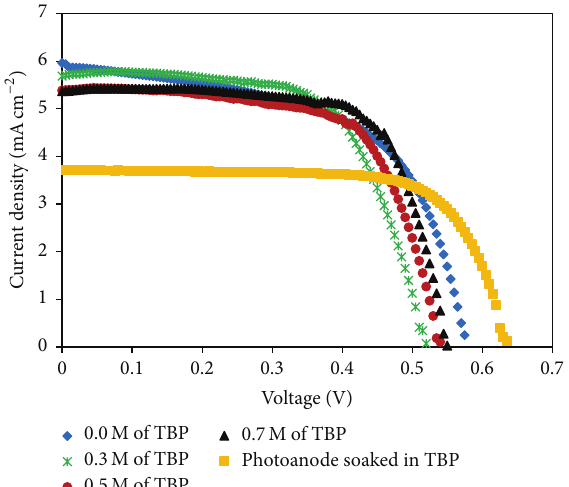
Figure 7: The 𝐽 - 𝑉 characteristics for DSSCs with double salt PVA electrolyte containing various amounts of TBP and that of the DSSC with photoanode soaked in TBP for 1h.